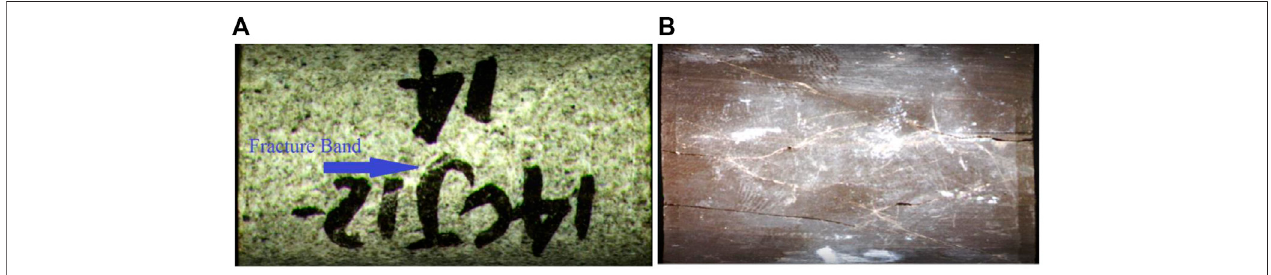
FIGURE 1 | Core photos after triaxial fracturing. (A) A post-frac sandstone. The fractures are barely opened and distributed in the form of faint bands. (B) A post- frac shale. Some fractures are fi lled with fragmental products, appearing white. The un fi lled fractures are